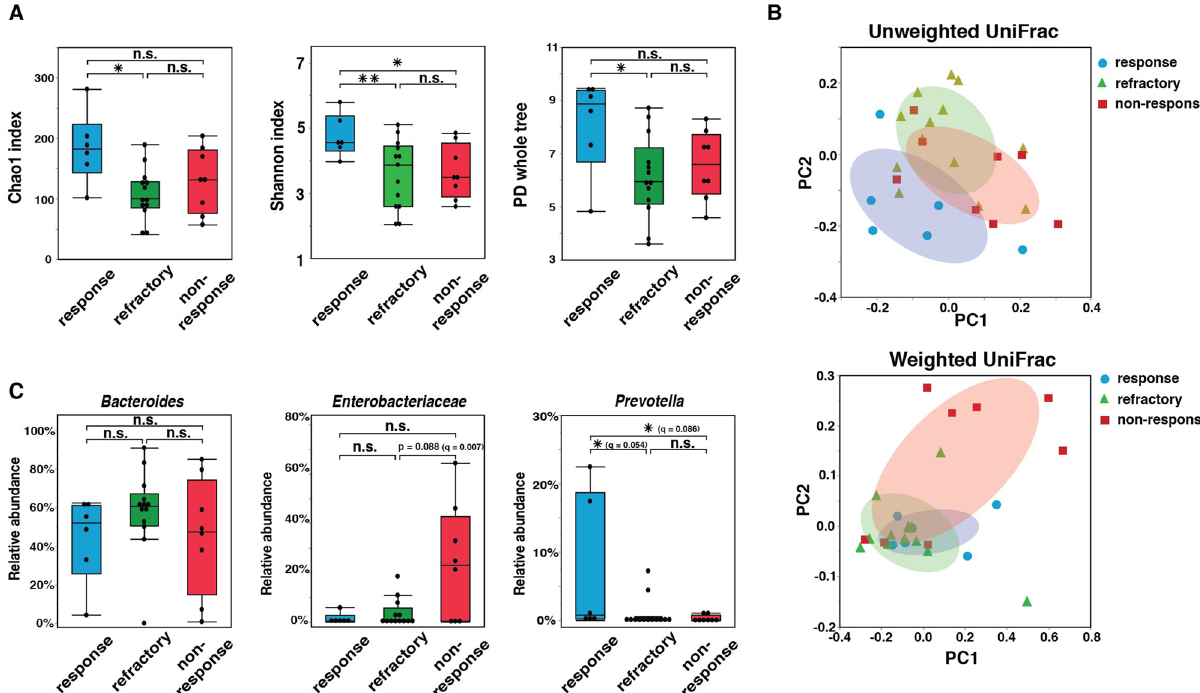
Figure 3. Comparison of gut microbiota composition in endoscopically active group among response, refractory, and non-response groups according to later clinical course. (A) Comparisons of α-diversity of gut microbiota composition among response (n = 6), refractory (n = 6), and non-response groups (n = 6) as assessed by the Chao1 index, the Shannon index, and whole-tree phylogenetic diversity (PD). (B) Principal coordinate analysis of gut microbiota by unweighted and weighted UniFrac among response (n = 6), refractory (n = 13), and non-response groups (n = 8). Each ellipse indicates 50% probability. (C) Comparison of taxonomic composition of microbiota including Bacteroides , Enterobacteriaceae, and Prevotella among response (n = 6), refractory (n = 13), and non-response groups (n = 8). *Statistically significant difference between the 2 indicated groups (p < 0.05). **Statistically significant difference between the 2 indicated groups ( p < 0.01). n.s., no significant difference between the 2 indicated